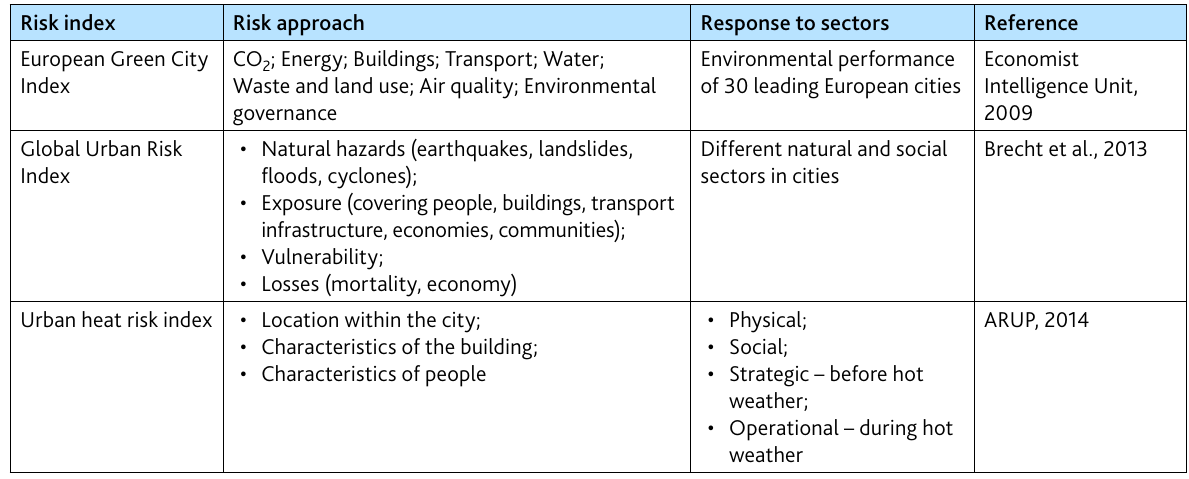
Table 1. Review of the developed risk indices and possible further